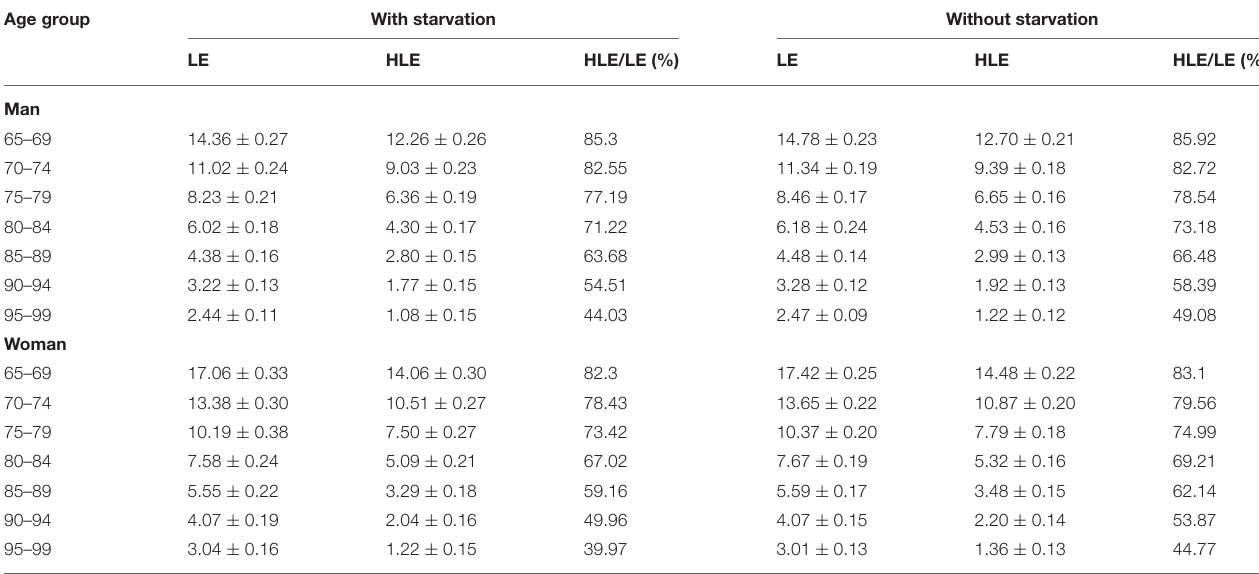
TABLE 2 | Comparison of healthy life expectancy among the elderly population (x ±